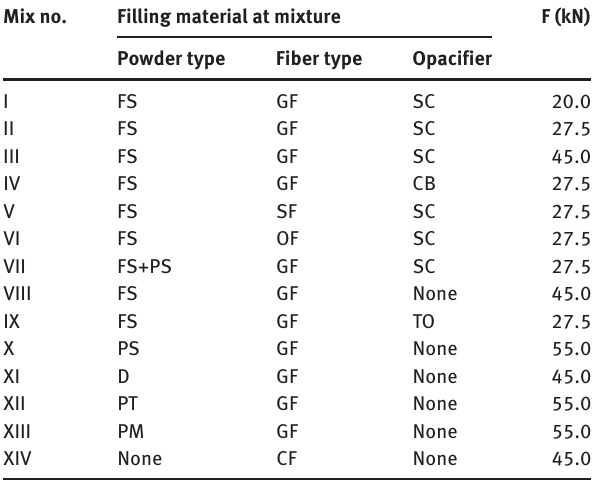
mixing ratios are given in Figure 4. The relationship between mass per volume ( γ ) and thermal conductivity coefficients ( λ ) of core samples are explained in Equations (1) and